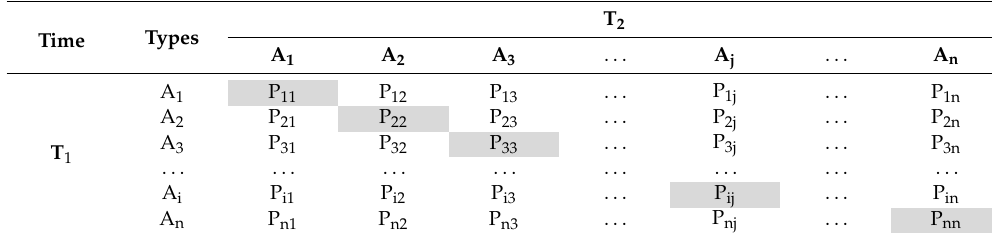
Table 3. Land-use/cover transition